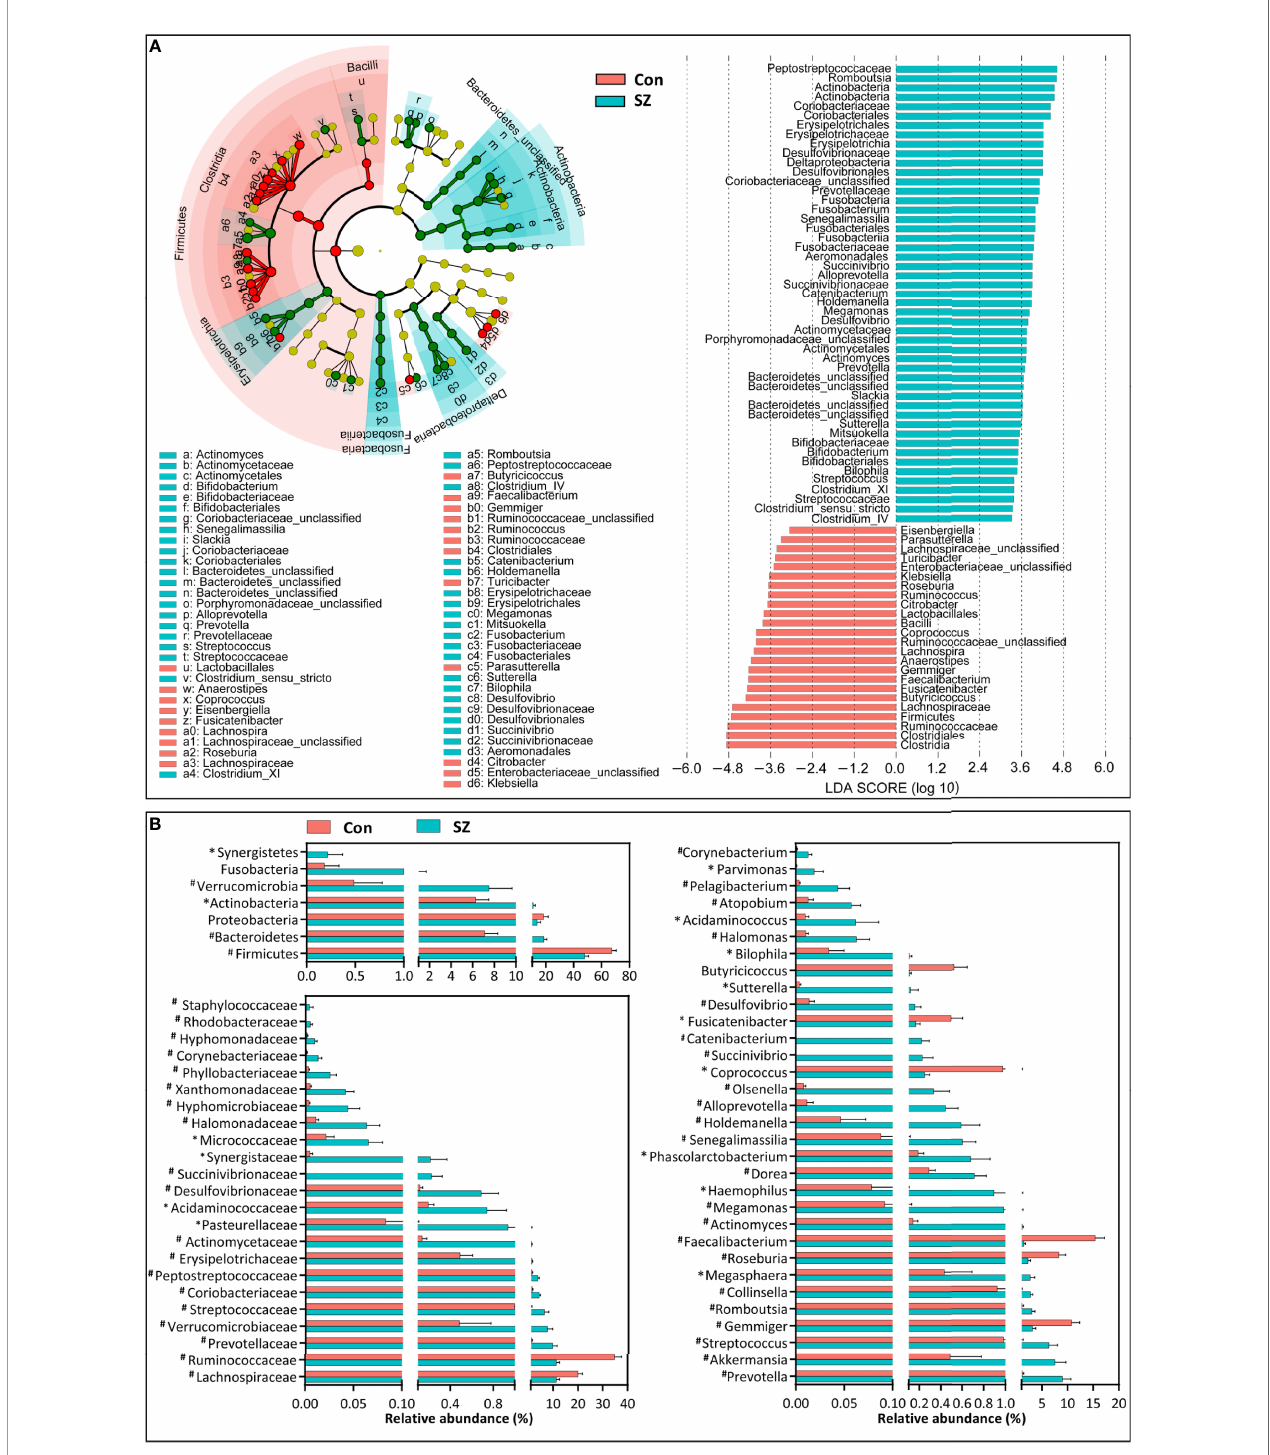
FIGURE 2 | Differential bacterial taxa between the elderly SZ patients and the healthy controls. The LEfSe identi fi ed the taxa with the greatest differences in abundance between the elderly SZ patients and the healthy controls. Only the taxa meeting a signi fi cant LDA threshold value of > 3 are shown (A) . Comparisons of the relative abundance of the abundant bacterial taxa at the level of bacterial phylum, family, and genus (B) . The data are presented as the mean ± standard deviation. Mann – Whitney U -tests were used to analyze variation between the elderly SZ patients and the healthy controls. *p < 0.05 and # p < 0.01 compared with the control